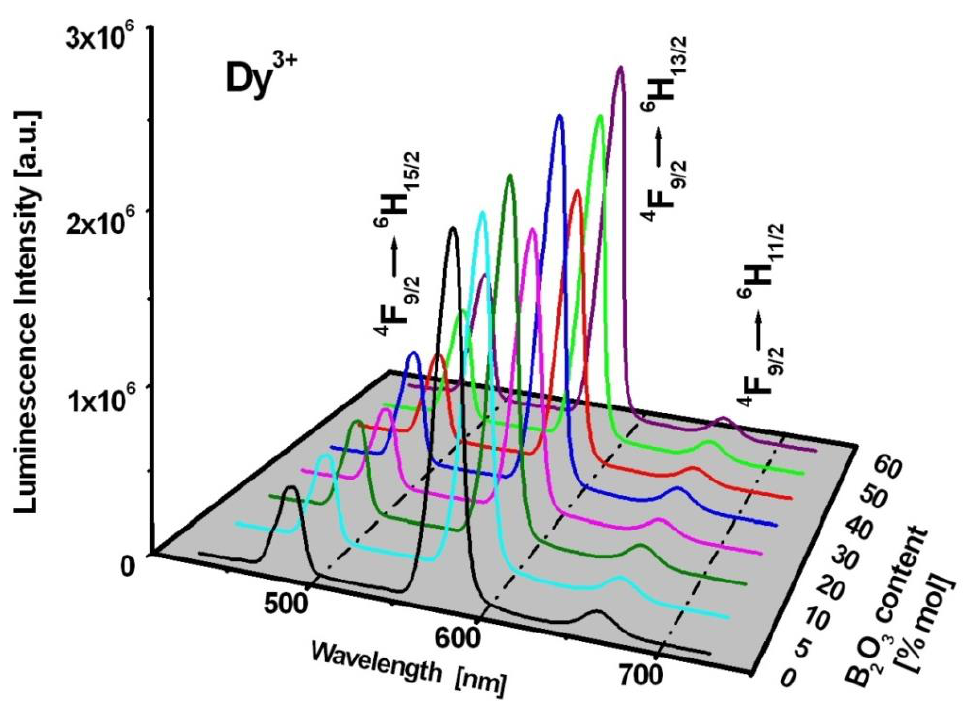
Figure 4. Luminescence spectra for borogermanate glasses doped with Dy 3+ .